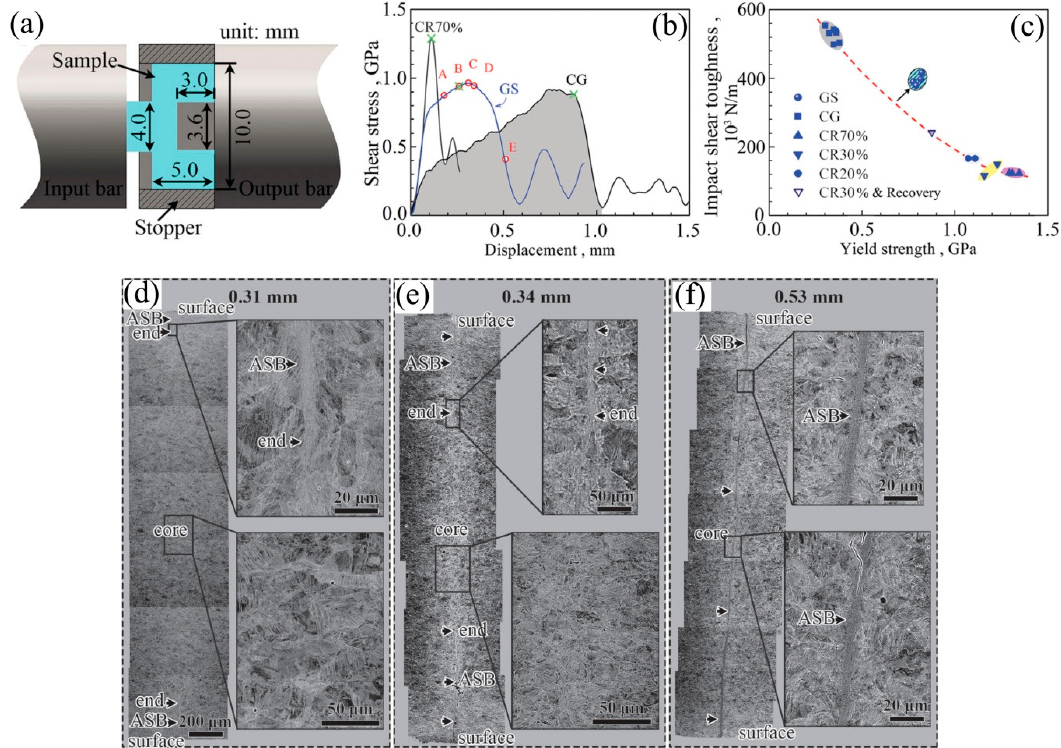
Figure 9. Dynamic shear properties and corresponding deformation mechanisms of gradient structure: ( a ) Set-up of dynamic shear experiments in Hopkinson bar; ( b ) Shear stress-shear displacement curves; ( c ) Impact shear toughness vs. dynamic shear yield strength; ( d – f ) Propagation process of ASB from the surface to the center. Adapted from [58].